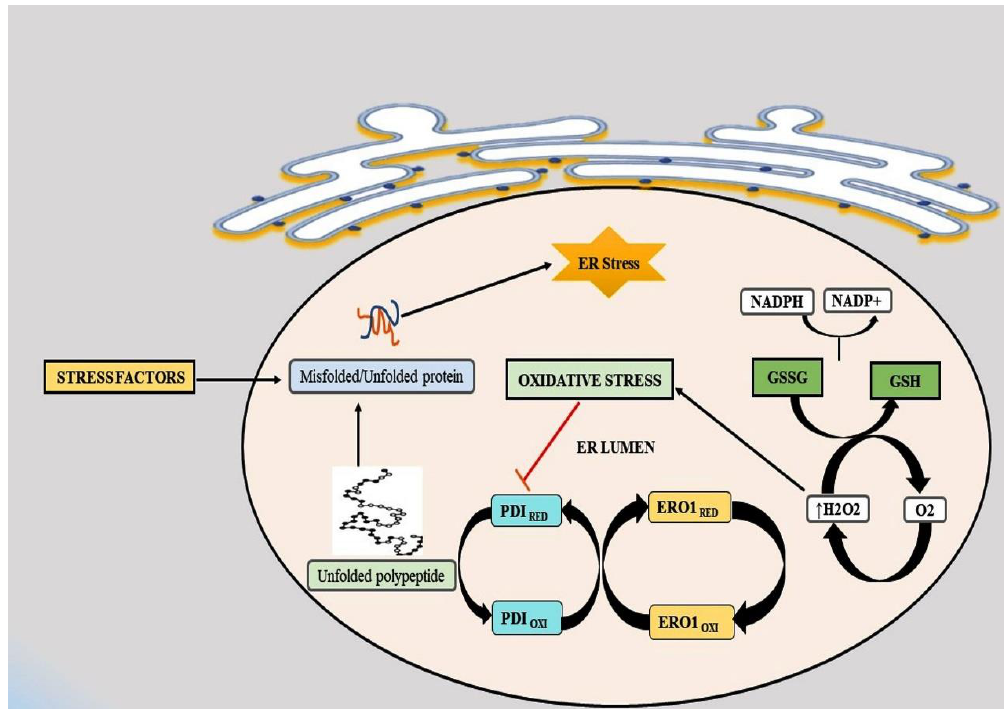
Figure 3. Protein folding in ER in the presence of oxidative stress. In eukaryotic cells, protein folding in ER is regulated by different proteins (PDI and ERO1). Impaired disulfide bond formation leads to the accumulation of misfolded proteins resulting in oxidative stress. Abbreviations: ER, endoplasmic reticulum; ERO1, ER oxidoreductin 1; FFA, free fatty acids; GSH, glutathione; GSSG, glutathione disulfide; NADPH, nicotinamide adenine dinucleotide phosphate; PDI, protein disulfide isomerase.